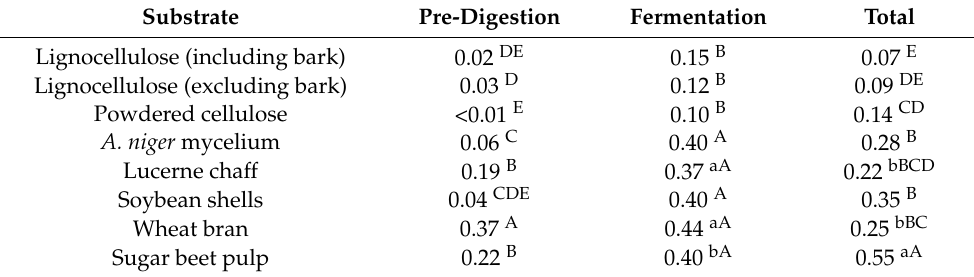
Table 9. Least squares means of in vitro dry matter digestibility coefficients after enzymatic pre- digestion, batch-culture fermentation (without pre-digestion), and in total (after fermentation of pre-digested material).